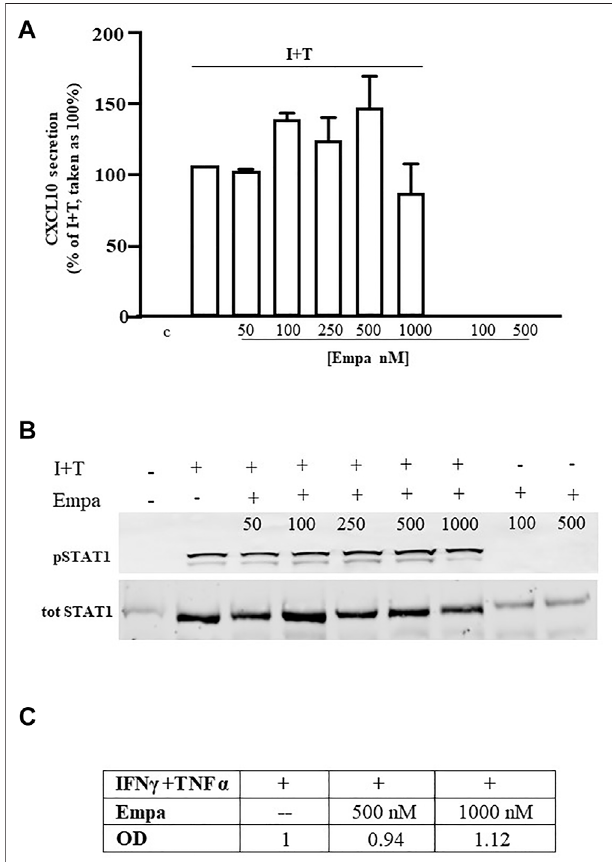
FIGURE2| EffectofEmpainhumanskeletalmusclecells. (A) InHskmc, Empa did not affect cytokine-induced secretion of CXCL10 at any tested concentration (50, 100, 250, 500, and 1,000 nM). Assays were run in quadruplicate in four different cell preparations ( n = 4); data were normalized vs. total protein amount and are expressed as percent of I + T-induced secretion (mean ± SE). Chemokine secretion was not detectable in control and in cells treated with Empa alone (500 – 1,000 nM). (B) Empa dose – response Western blot analysis in Hskmc protein extracts showed the lack of any effect onto the Stat-1 phosphorylated level; pStat-1 was undetectable in control cells and after the treatment of Empa alone (500 – 1,000 nM); experiments were performed in three different cell preparations ( n = 3), and a representative blot is